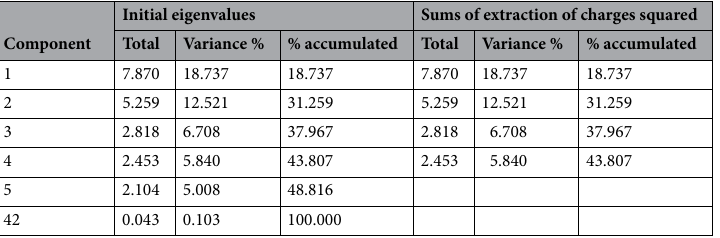
Table 4. Total variance explained by the four factors extracted according to the structure of the original APFQ.